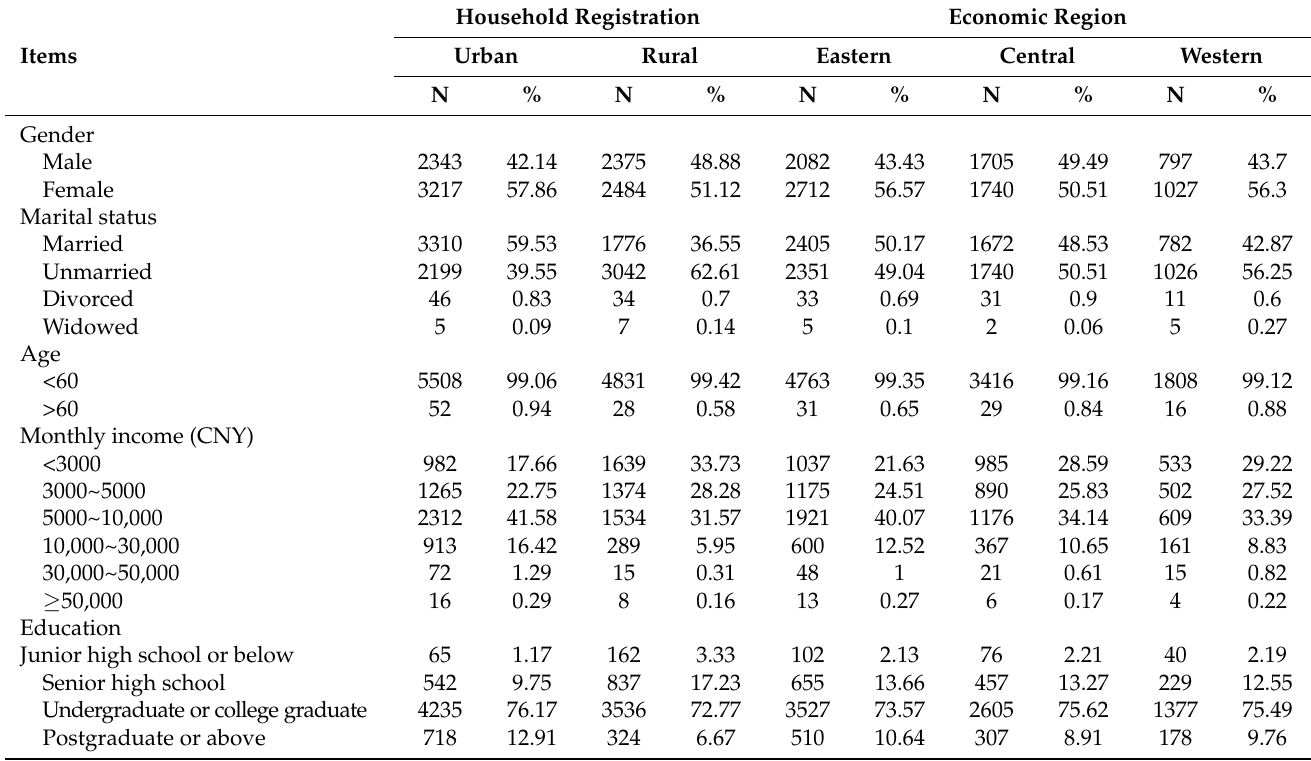
Table 1. Social demographic characteristics of participants.